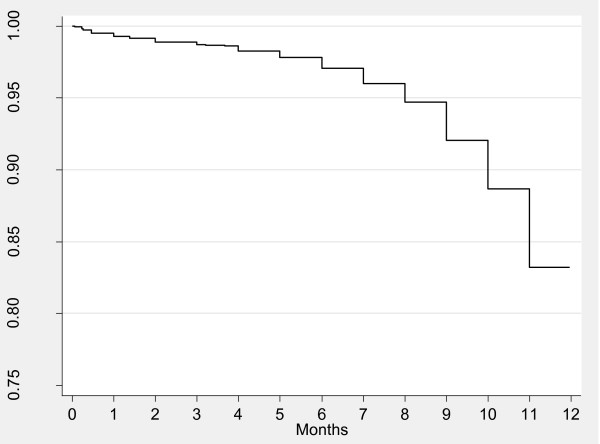
Probability of continuing breastfeeding for specific ages, Nairobi informal settlements, Kenya.